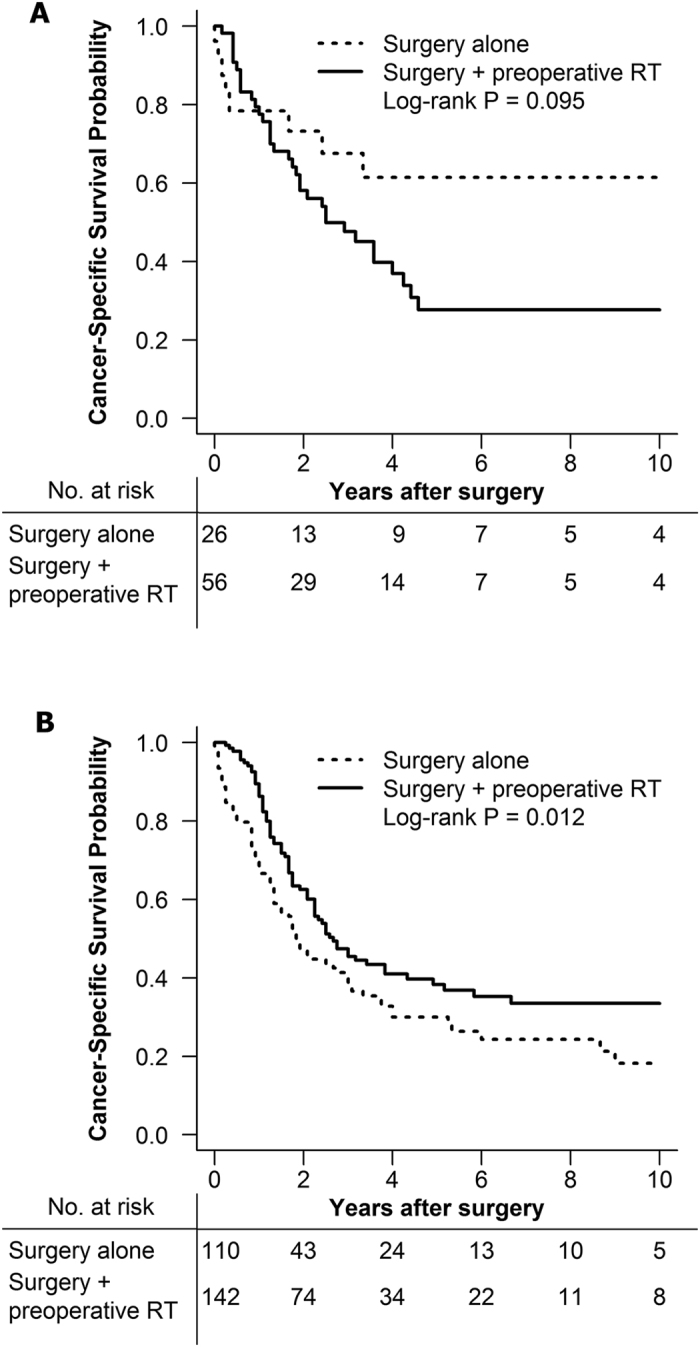
(A) Cancer specific survival for stage II rectal SRCC patients treated with or without preoperative radiotherapy. (B) Cancer specific survival for stage III rectal SRCC patients treated with or without preoperative radiotherapy. MC = mucinous adenocarcinoma; NMC = nonmucinous adenocarcinoma; SRCC = signet-ring cell carcinoma; RT = radiotherapy.